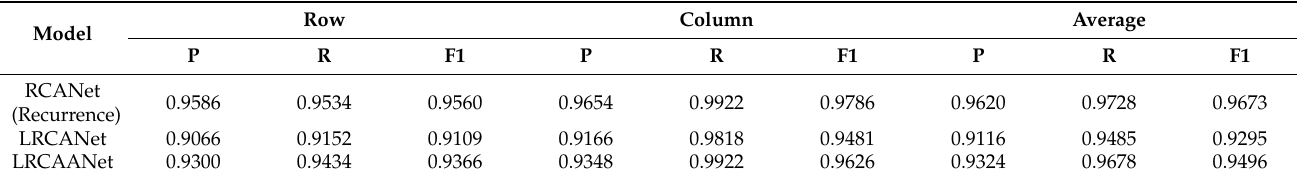
Table 5. Model performance